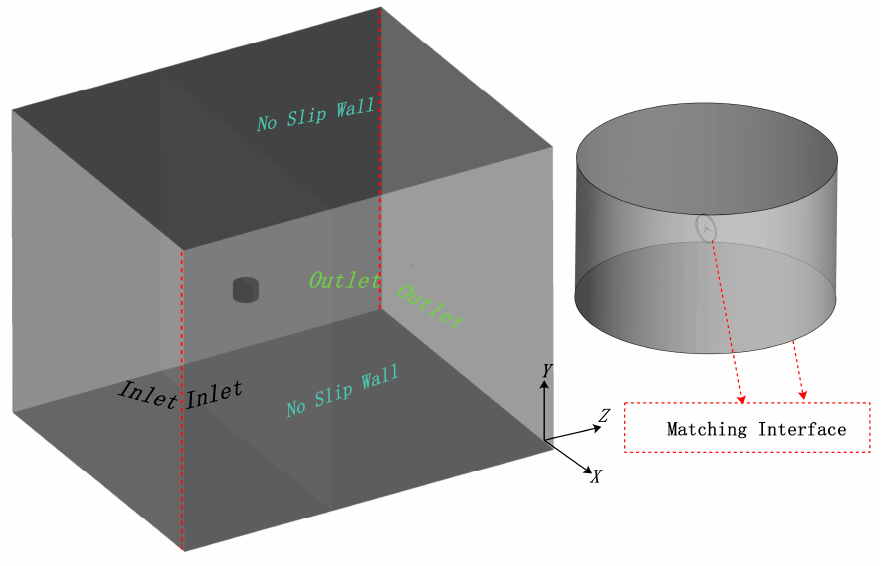
Figure 3. Boundary Figure 3. Boundary conditions. Figure 3. Boundary conditions.